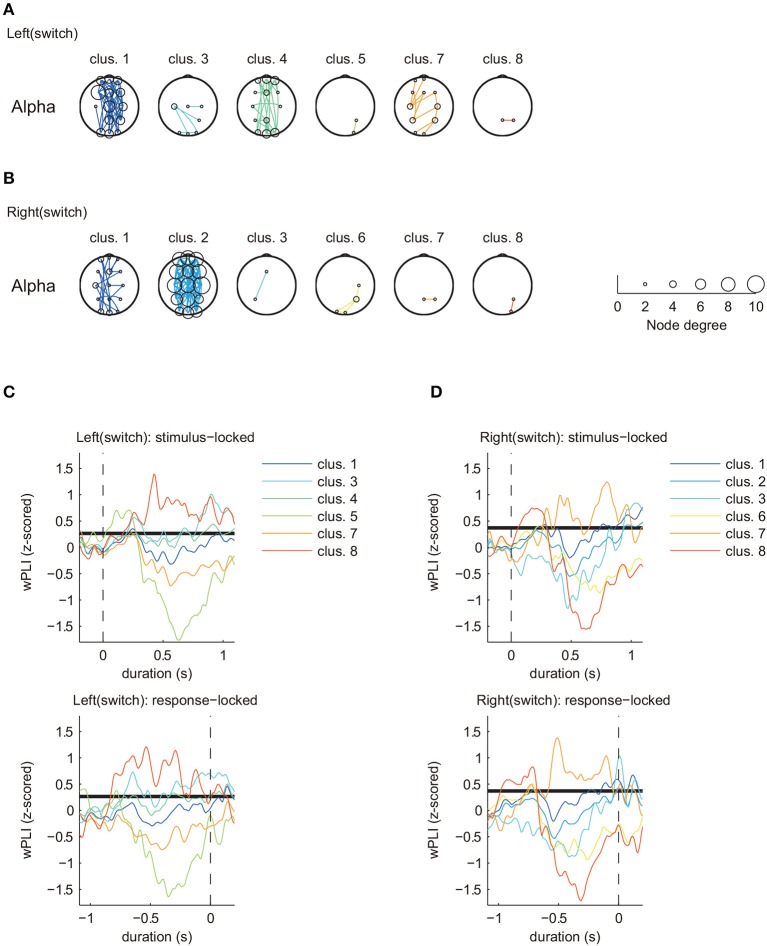
Estimated clusters and functional connectivity based on time series matching of z-scored wPLIs using DTW (MR task: switch trial, alpha band). (A) Estimated significant clusters of functional connectivity for left switch trials. Six of eight clusters were estimated to be significant. (B) Estimated significant clusters of functional connectivity for right switch trials. Six of eight clusters were estimated to be significant. Marker size of the electrodes for each topographical location corresponds with the node degree of connectivity. (C,D) Cluster-averaged z-scored wPLIs for each hand in the switch trials (upper panels: stimulus-locked average; lower panels: response-locked average). Bold black lines indicate a significant level of temporal changes in cluster-averaged phase-synchronization values (p < 0.05 with FDR correction).